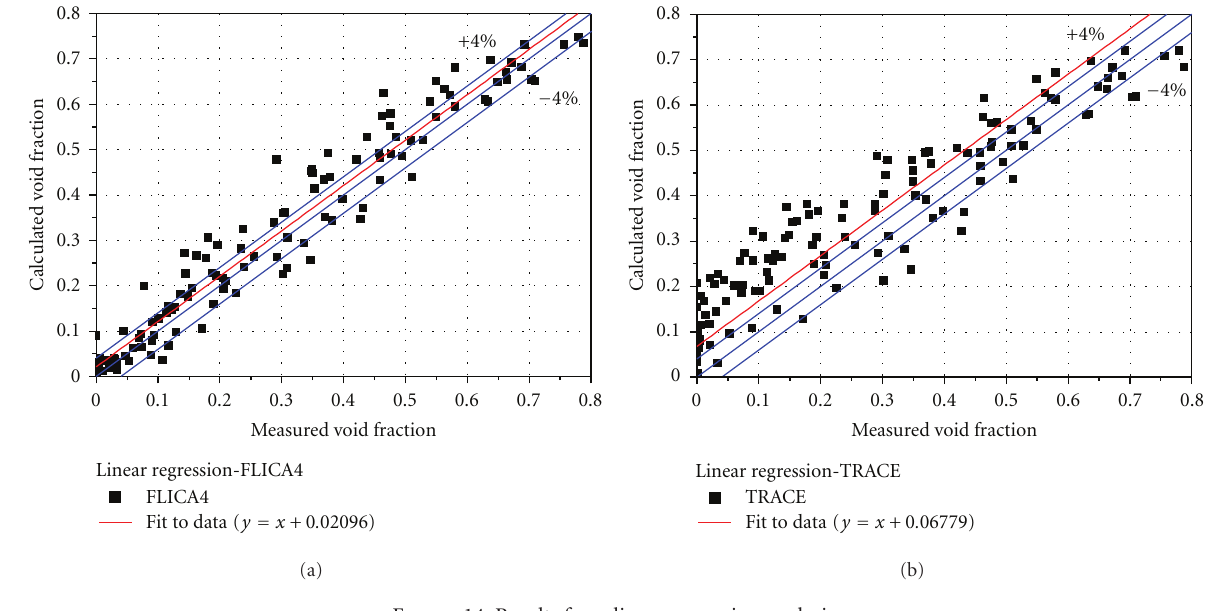
Figure 14: Results from linear regression analysis.